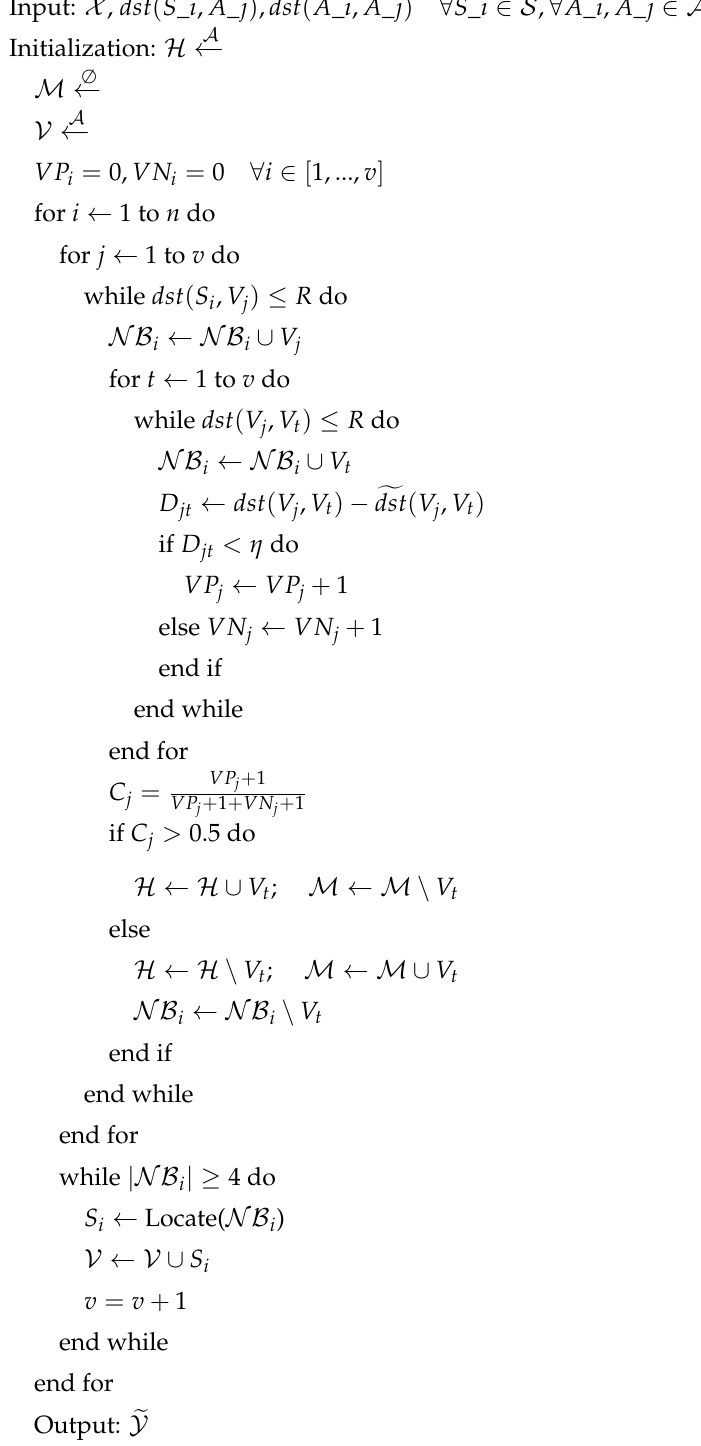
Algorithm 1 Pseudo-code for Malicious Voting-Based Cooperative Localization